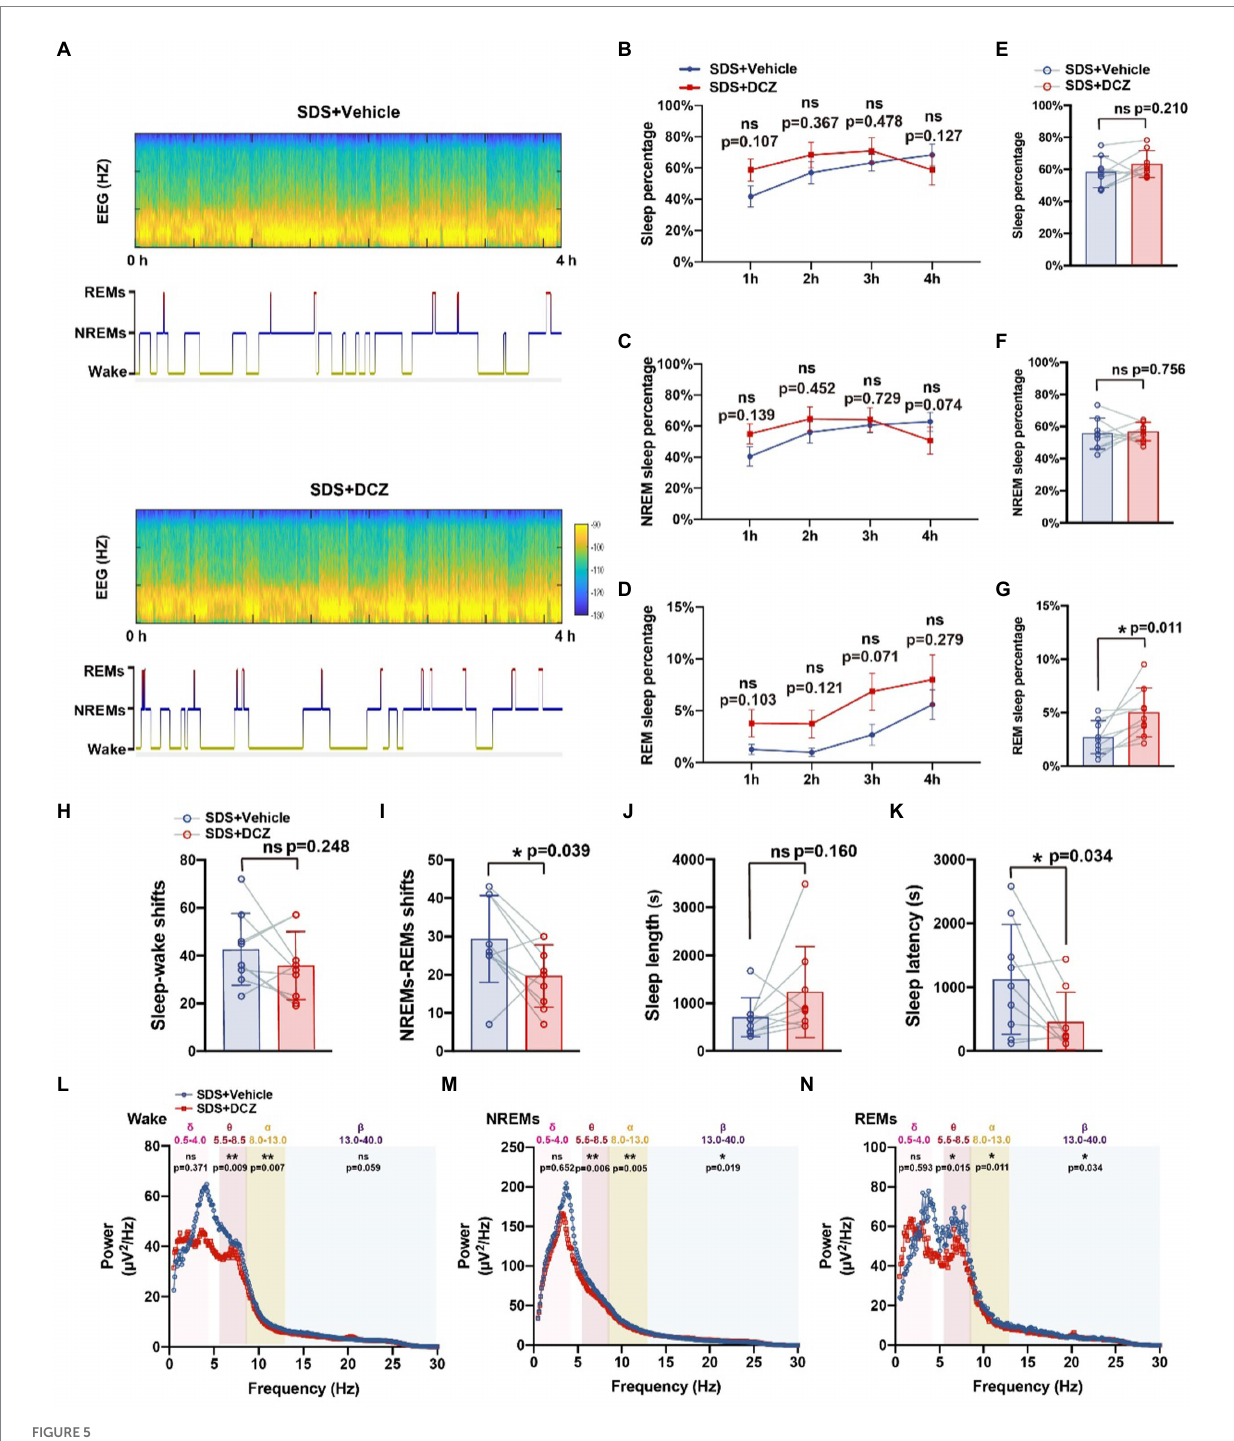
FIGURE 5 Activation of VTA vgat neurons promotes sleep quality after SDS in APP/PS1 mice. (A) Representative hypnograms of SDS + VTA Vgat vehicle or SDS + VTA Vgat activation round during the 4-h recording. (B–G) Quantitative analysis of the percentage of sleep, NREMs, and REMs in each hour (B,D,F) and in 4 h (C,E,G) . (H-K) Quantitative analysis of sleep–wake shifts, NREMs-REMs shifts, sleep length, and sleep latency in SDS + VTA Vgat vehicle, or SDS + VTA Vgat activation round during the 4-h recording. (L–N) EEG Spectral plot and average wave power in wake, NREMs, and REMs in SDS + VTA Vgat vehicle or SDS + VTA Vgat activation round. n = 9, paired t